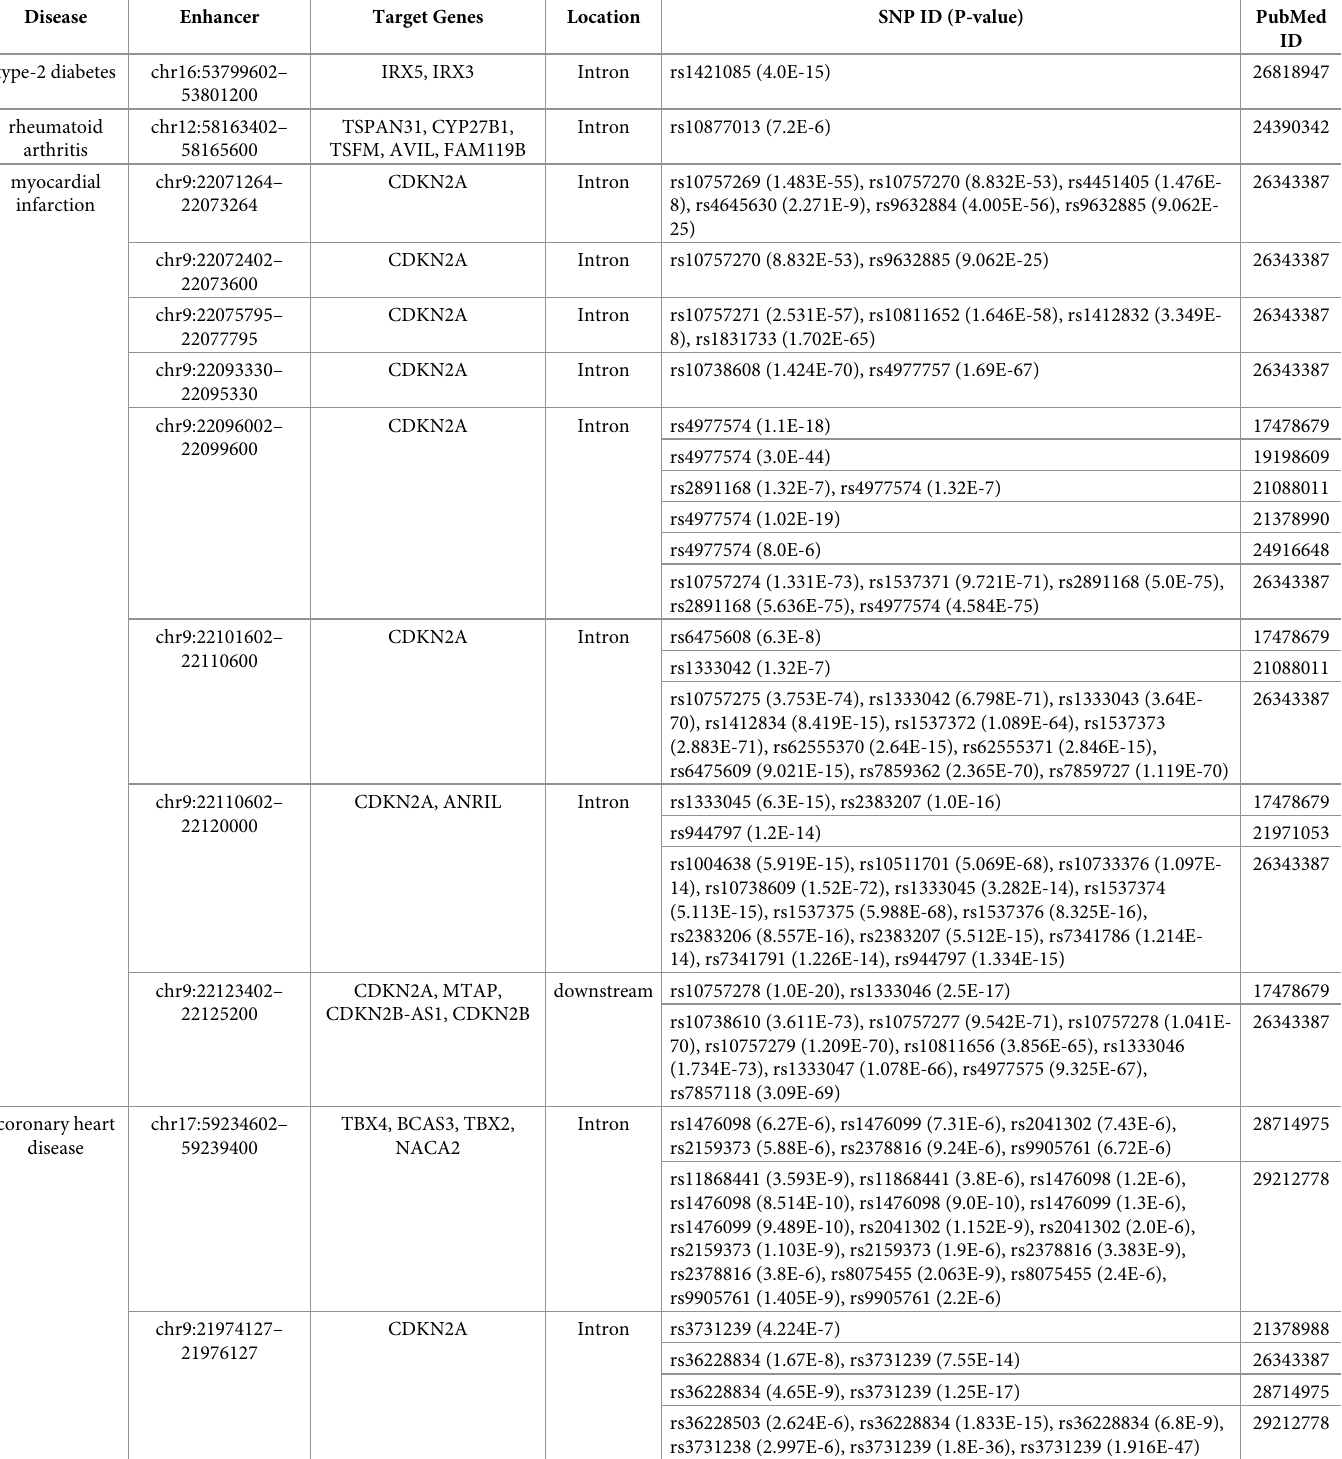
Table 1. Enhancers directly associated with four diseases from genome-wide association studies.